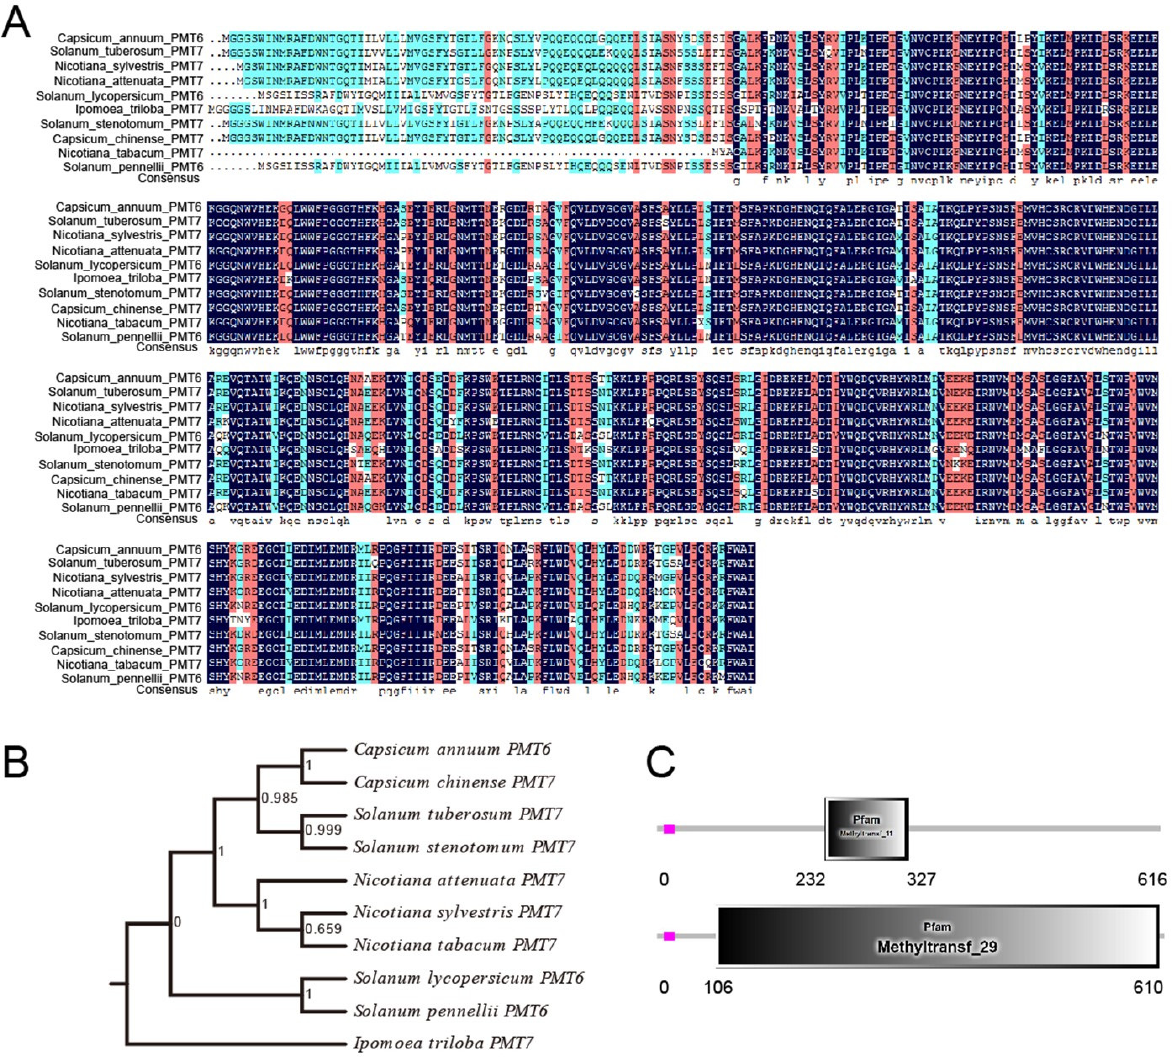
Figure 1. Analysis of amino acid sequence of pepper CaPMT6 and the multiple alignment of CaPMT6 with its orthologues in other plant species. ( A ) Multiple alignment of amino acid sequences deduced from pepper CaPMT6 with its orthologues from other plant species, including Solanum tuberosum , Nicotiana sylvestris , Nicotiana attenuata , Solanum lycopersicum , Ipomoea triloba , Solanum stenotomum , Capsicum chinese , Nicotiana tabacum , and Solanum pennellii . Blue shading, 50–75% identity; red shading, 75–100% identity; and black shading, 100% identity. ( B ) Phylogenetic analysis of CaPMT6 with its orthologs in other plant species. ( C ) Two highly conserved methyltransferase domains in CaPMT6 amino acid